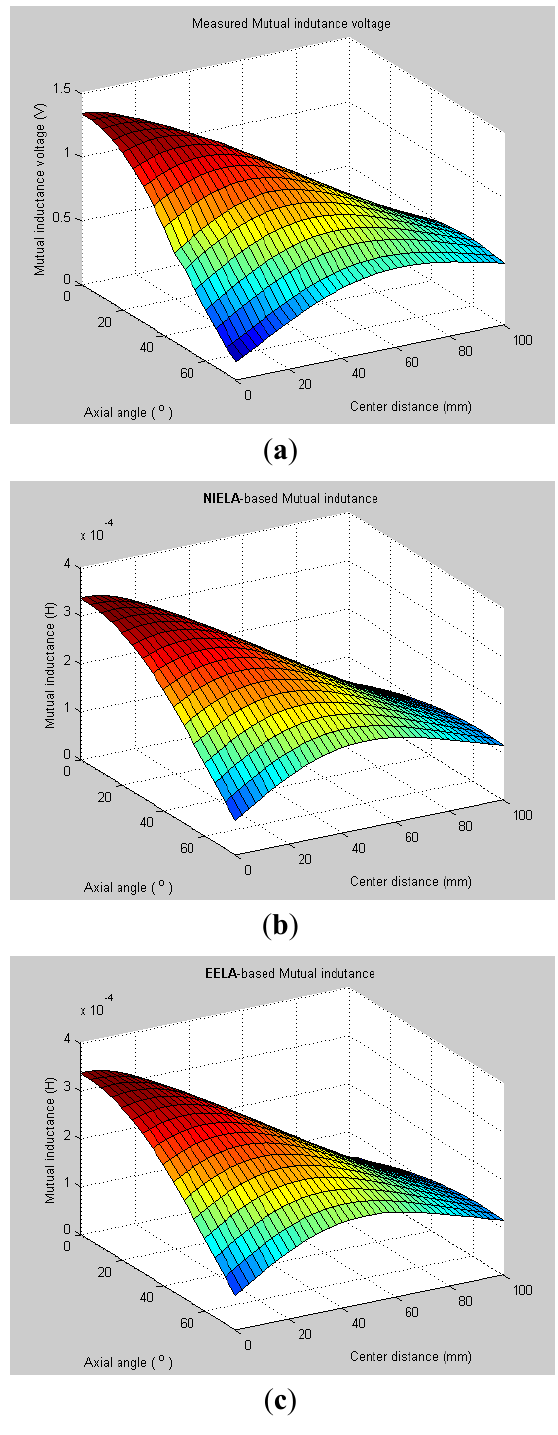
Figure 5. 3-D graphs of ( a ) measured mutual inductance voltage; ( b ) NIELA -based mutual inductance; ( c ) EELA -based mutual inductance versus center distance and axial angle between Solenoid I and II ( Z = 115